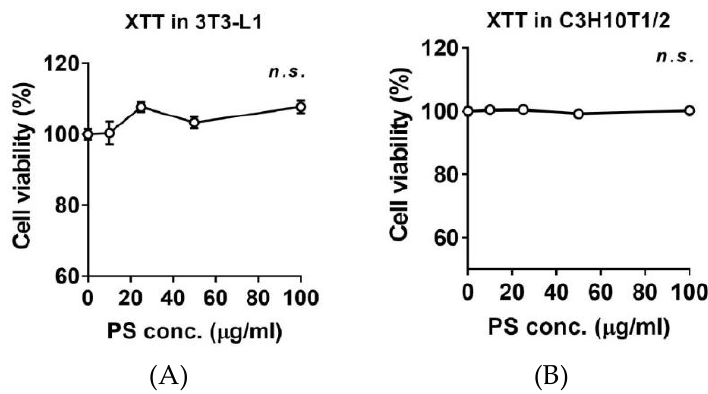
Figure 1. Effects of PSE on cell viability in 3T3-L1 and C3H10T1/2 pre-adipocytes. The culture of 3T3-L1 ( A ) and C3H1051/2 cells ( B ) were treated with 10-100 µ g/mL of PSE for 24 h. XTT reagent was added 3 h before measurement of OD 450 nm. Data are expressed as a percentage of the vehicle control (dimethyl sulfoxide (DMSO)). n.s. represents no significance. Data are represented as the mean ± SEM of three independent experiments. Values that do not share the same superscript are significantly different, as determined by one-way ANOVA ( p < 0.05).